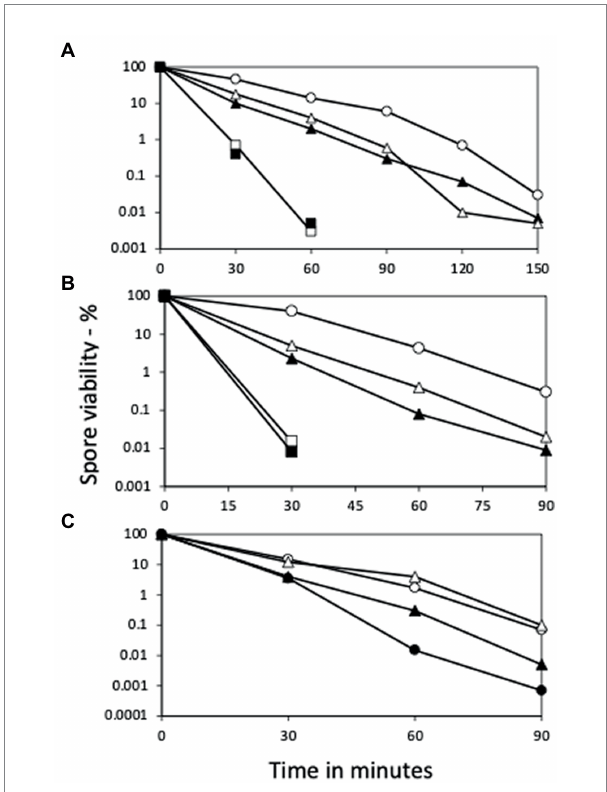
FIGURE 2 Wet heat killing of spores of various strains with and without ydfS and yetF mutations, and with and without antibiotic markers. Spores of B. subtilis strains were incubated in water at (A) 90 ° C or (B) 93 ° C or (C) 93 or 98 ° C for various times, samples diluted 1/10 in cold water, then diluted serially 1/10-fold, 10 μ L aliquots spotted on LB plates without antibiotics, incubated at 30 ° C and then 37 ° C until no more colonies appeared, and colonies were counted, all as described in Methods. The symbols for the spores used in the figures are: (A) ○ – PS533 (wt), ▲ – PS4481 ( ydfS Km r ), □ – PS4482 ( yetF Km r ), is △ – PS4483 ( ydfS Em r ), and ■ – PS4484 ( yetF Em r ); (B) ○ – PS832 (wt), △ – PS4481 ( ydfS Km r ), □ – PS4482 ( yetF Km r ), ▲ – PS4487 ( ydfS ), and ■ – PS4488 ( yetF ); and (C) at 93 ° C ○ – PS4461 (wt); ● – PS4489 (PS4461 yetF ), and at 98 ° C with △ – PS4462, and ▲ – PS4490 (PS4462 yetF ). Data are averages from three separate experiments and results varied by ≤